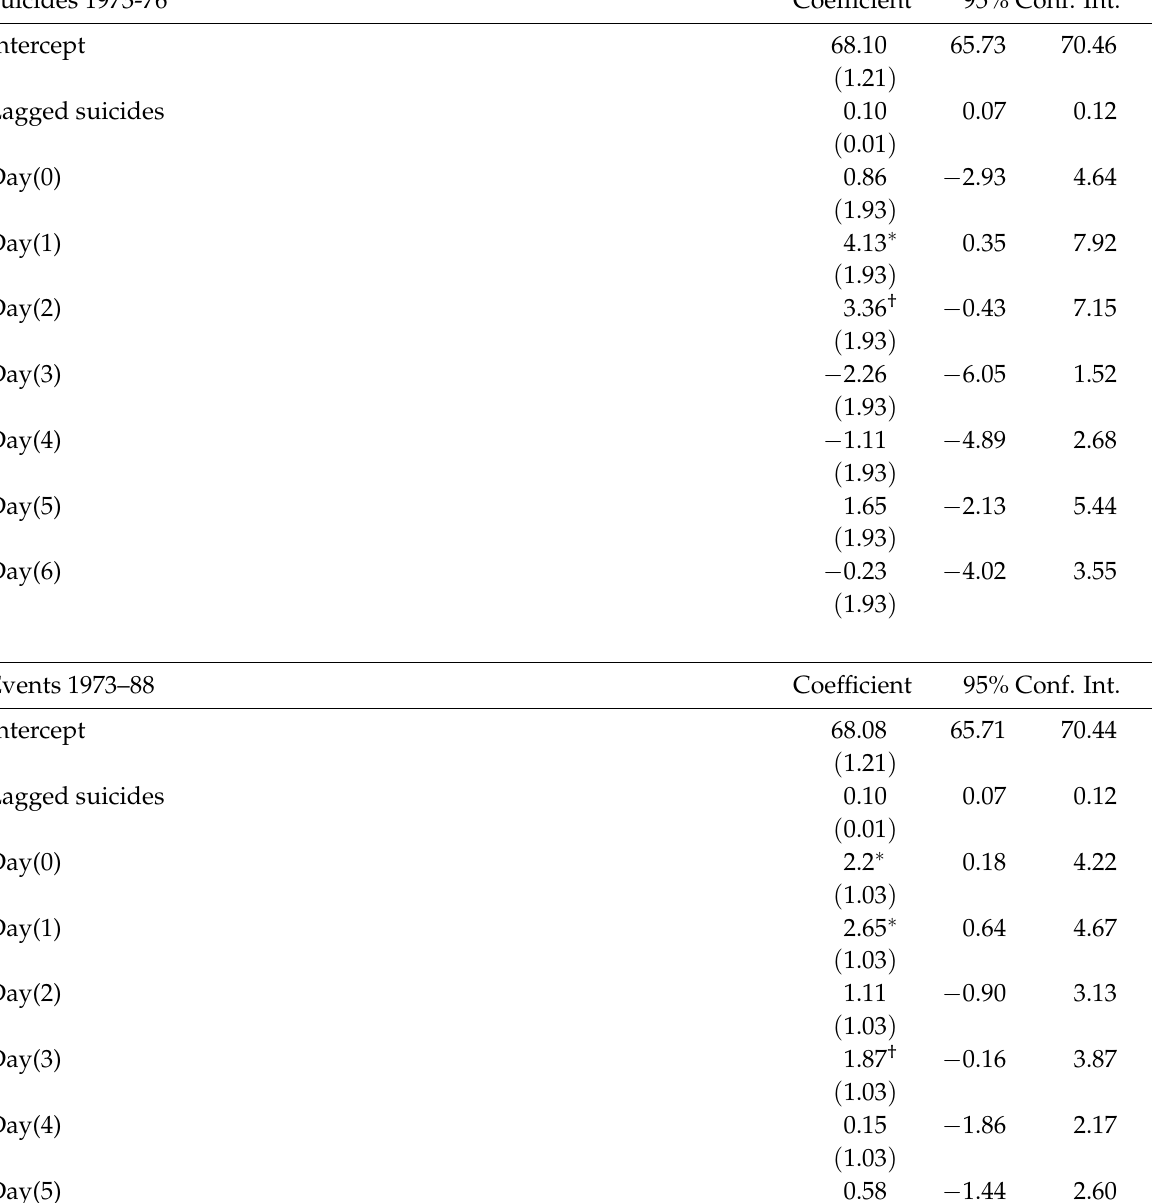
Table 3: The effect of celebrity suicide and exceptional events on daily suicide, 1973-1988 Suicides